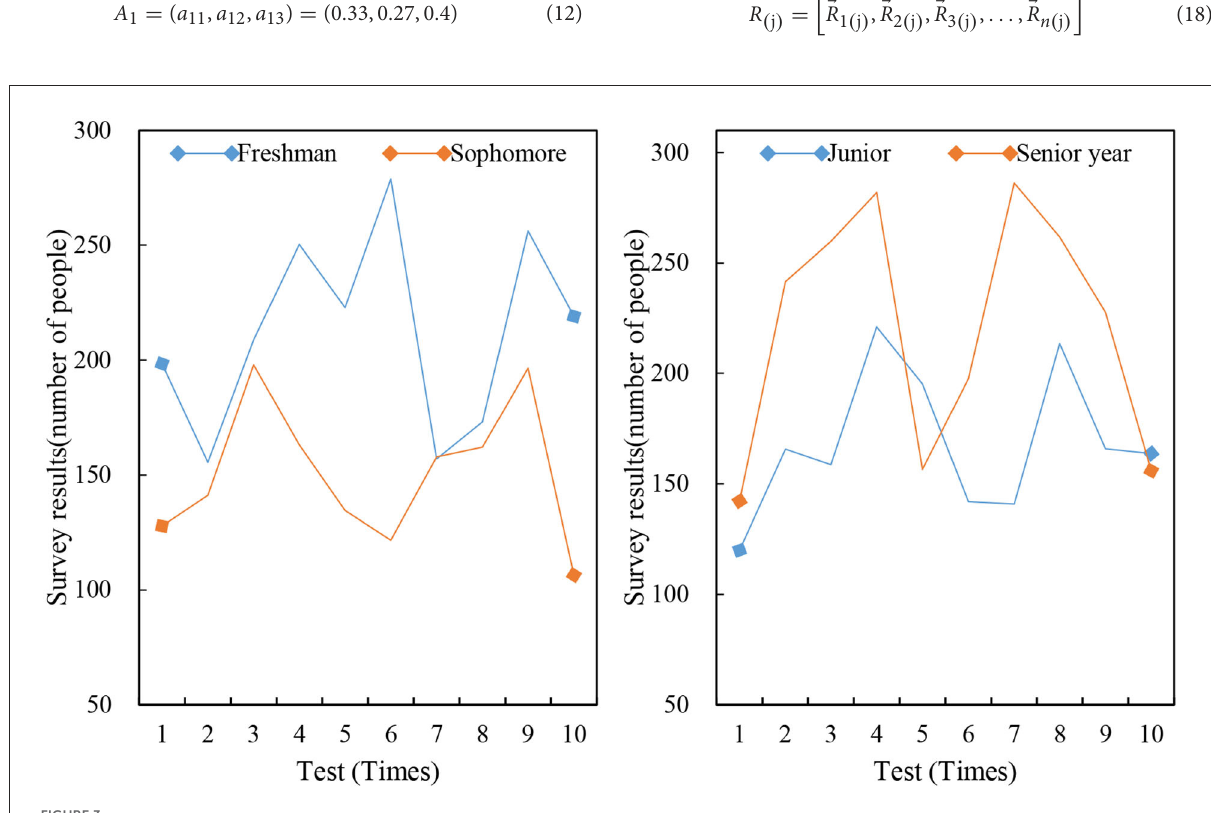
FIGURE3 Number of freshmen to